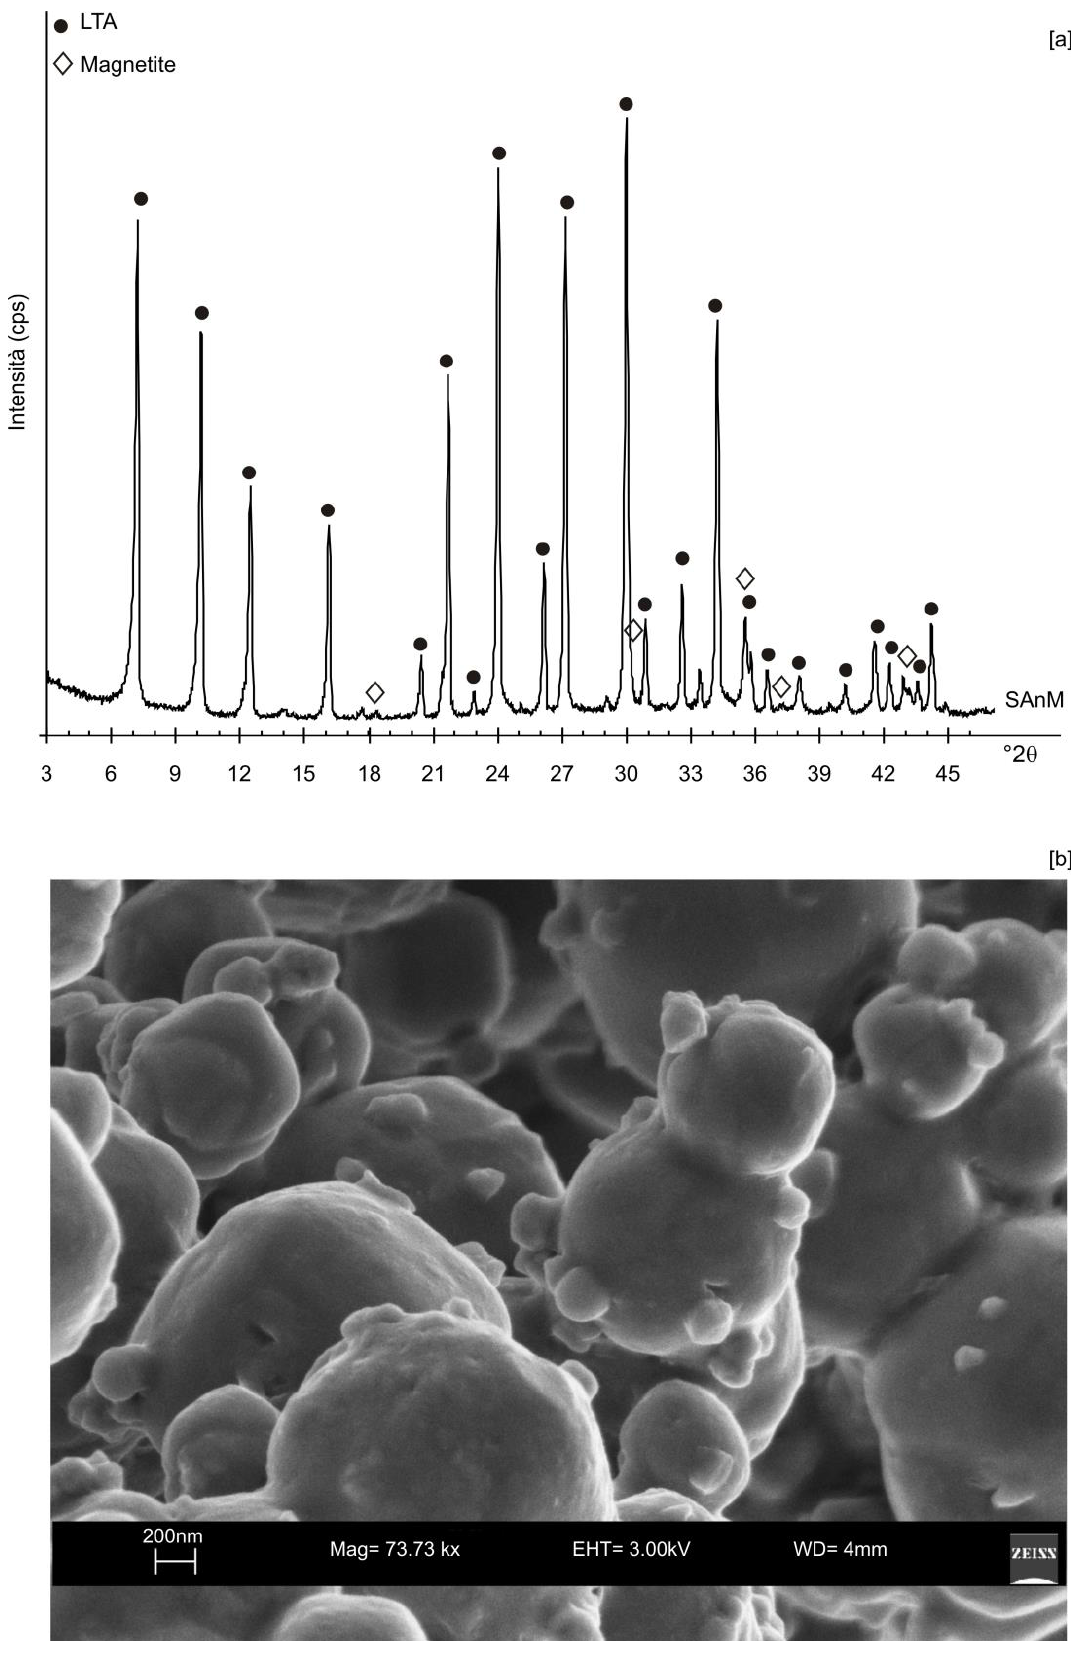
Figure 3. XRD pattern ( a ) and SEM image ( b ) of SARM sample. Figure 2. XRD pattern ( a ) and SEM image ( b ) of SAnM